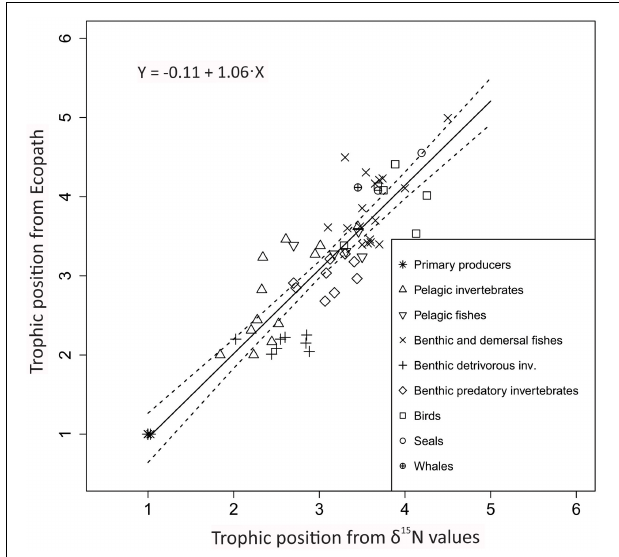
FIGURE 2 | Comparison of trophic positions estimated through Ecopath ( y -axis) and average trophic positions for each functional group ( x -axis) from stable isotopes (TP SIR ) based on TP values reported in the literature sources. Symbols are shown for aggregated categories. Continuous line shows linear regression line and stippled lines show 95% confidence intervals.